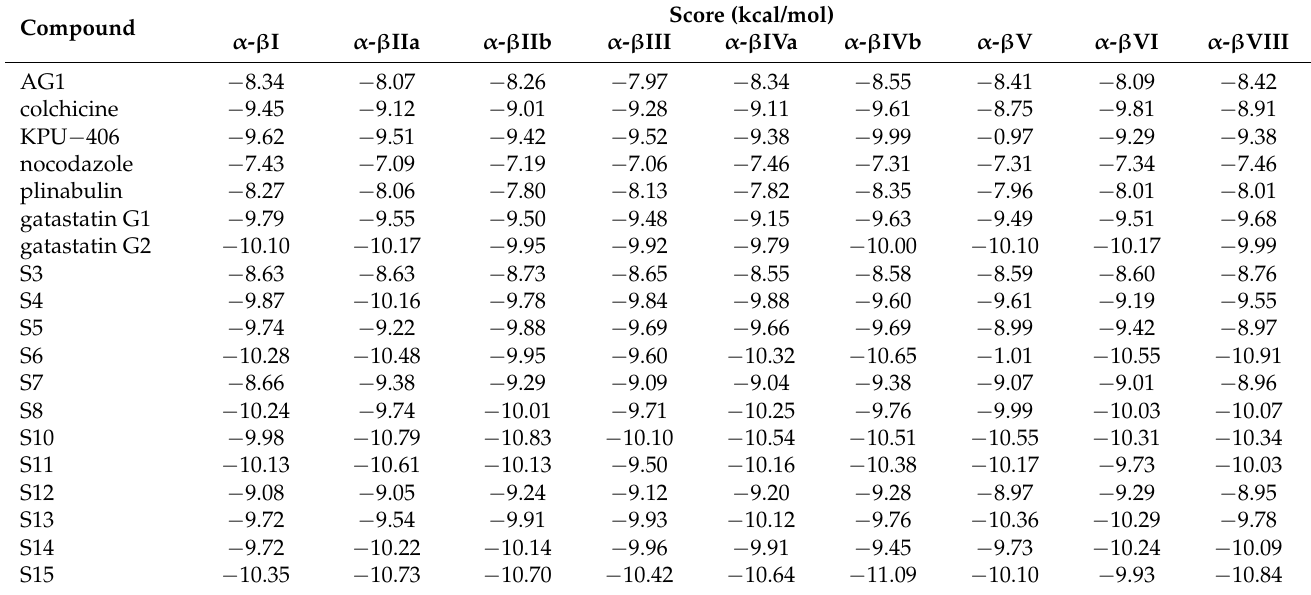
Table 5. Binding scores of the analyzed ligands resulting from docking simulations in the colchicine binding sites of α - β